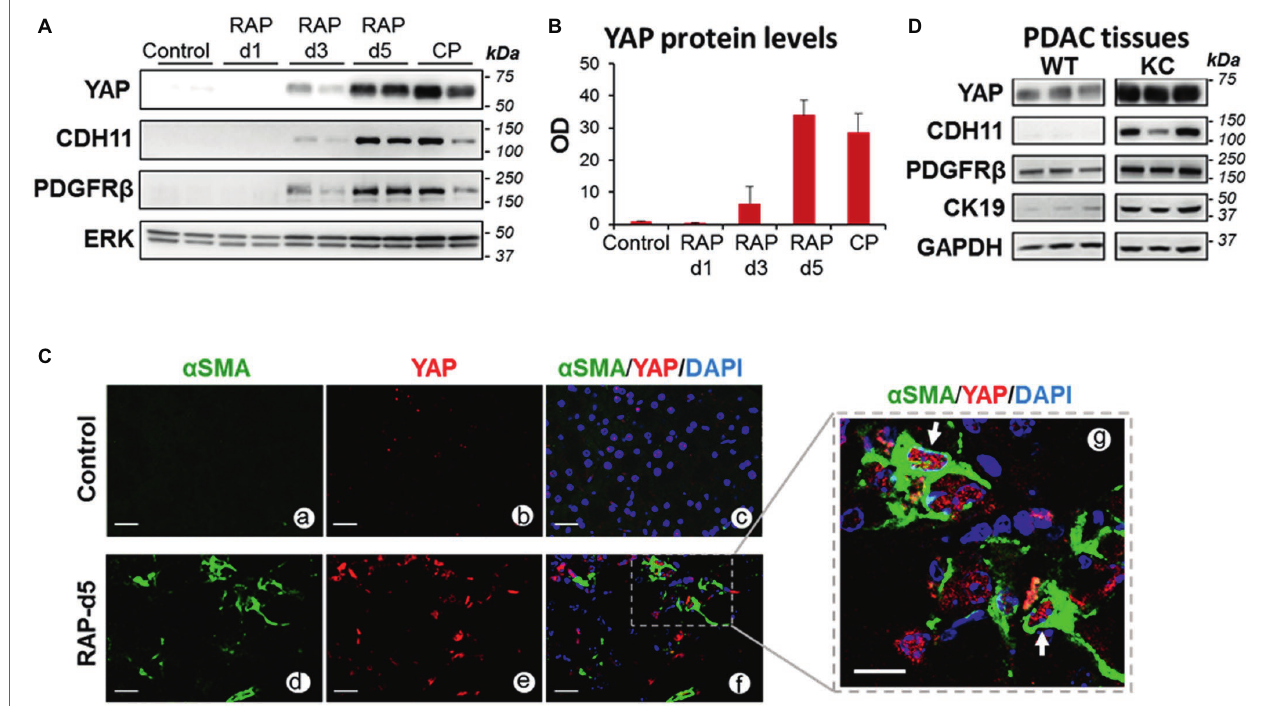
FIGURE 1 | YAP levels increase in pancreas during parenchyma remodeling in pancreatic disease. (A) Representative immunoblots showing protein levels of YAP and the PaSC markers Cadherin 11 (CDH11) and the PDGF receptor PDGFR β in pancreas of mice subjected to repeated episodes of cerulein acute pancreatitis: RAP ; two episodes, 1 day apart; CP , chronic pancreatitis, two episodes per week for 4 weeks. As indicated in the “Methods” section, mice were sacrificed during the acute phase of pancreatitis ( d1 , day 1, one AP episode; d3 , day 3, two AP episodes), 2 days after two AP episodes ( d5 ) or 4 days after the last episodes in the CP model. ERK1/2 was used as loading control. Each lane shows data from an individual mouse; two mice per group are shown. Data are representative of five mice per group. (B) Graph shows quantitation of optical density of YAP bands in immunoblot shown in panel A relative to those of ERK1/2. Data are mean ± SEM, n = 5 mice/group. (C) Paraffin- embedded pancreatic tissues obtained from mice subjected to two episodes of AP (days 1 and 3) and sacrificed at day 5 ( RAP-d5 ) or saline-treated mice ( Control ) were analyzed for the PaSC marker α SMA and YAP by immunofluorescence. Nuclei were counterstained with DAPI. Panels a–f show representative immunofluorescence staining; Scale bar = 25 μ m. Dotted box in panel f shows α SMA-positive PaSC displaying YAP staining in the nucleus; the dotted area is shown higher magnified in panel g . Arrows in panel g show positive YAP nuclei. Scale bar = 10 μ m. Control tissues (panels a–c ) do not exhibit activated PaSC or significant YAP staining. Data are representative of three mice per group. Representative H&E stained images from control and RAP-5d mice pancreas are shown in Supplementary Figure S1A . (D) Representative immunoblots showing protein levels of YAP, the PaSC markers CDH11 and PDGFR β , the ductal marker Cytokeratin 19 (CK19) in pancreas of 2-month-old wild-type ( WT ) and Ptf1-Cre;LSL-Kras G12D/+ ( KC ) mice. GAPDH was used as loading control. Each lane shows data from an individual mouse; three mice per group are shown. Representative photomicrographs from KC mouse pancreas showing a-SMA positive PaSC are included in Supplementary Figure S1B